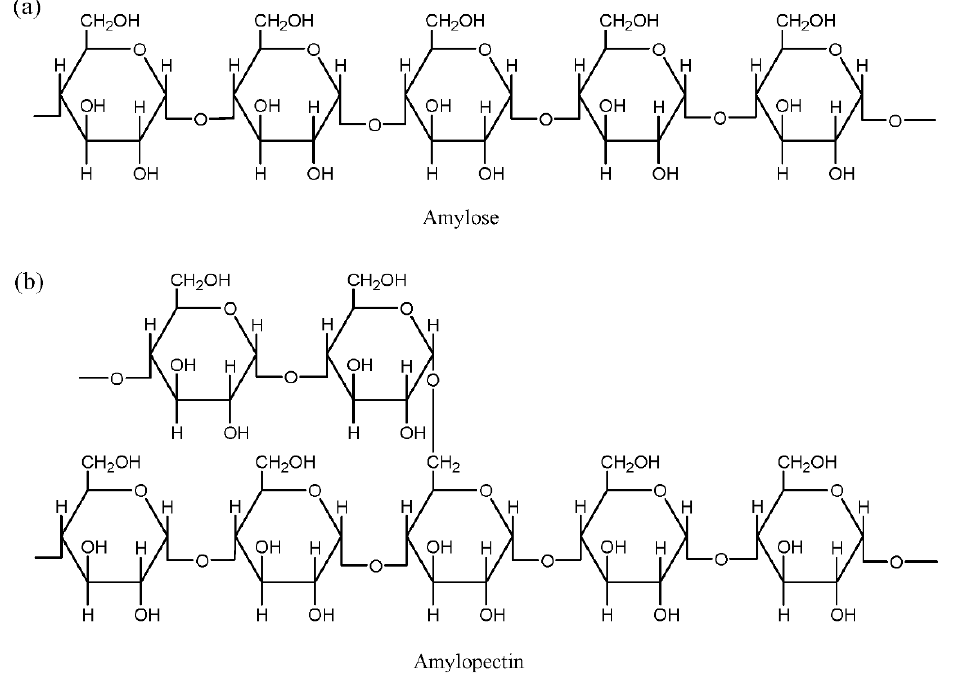
Figure 4. Representative units of starch ( a ) amylose and ( b ) amylopectin.